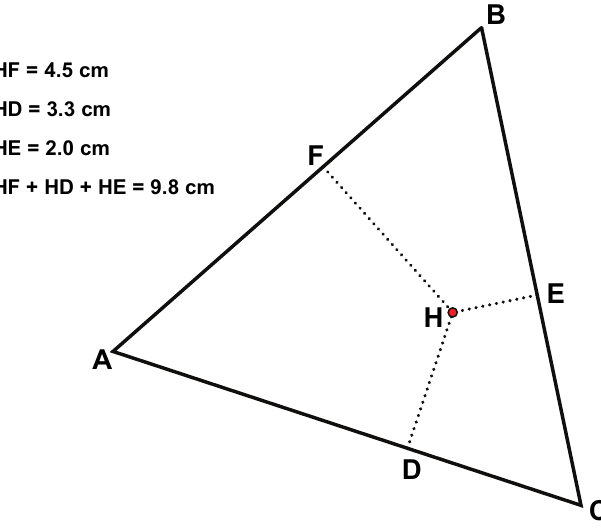
Figure 6 : Learners’ attempt to find the optimum position of the